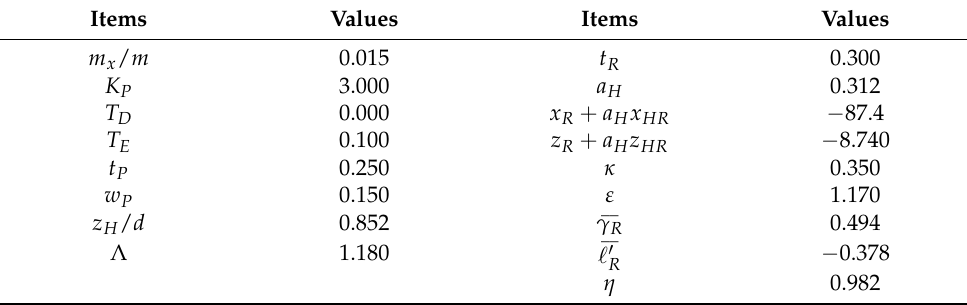
Table 2. The parameters used in this mathematical model. Items Values Items Values m x / m